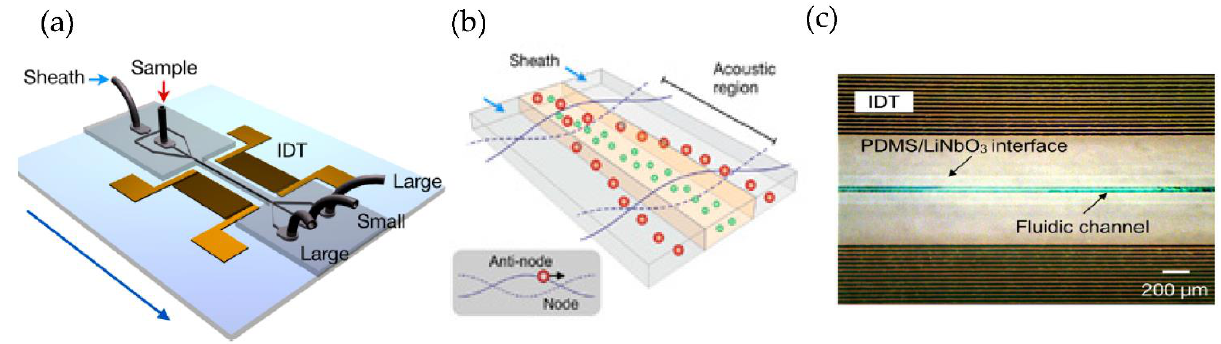
Figure 11. Experimental strategy for exosome immobilization and characterization using ExoChip ( a ) Schematic of exosome capture and analysis used in ExoChip. ( b ) Schematic for CirEVs fluorescence detection in micro-plate readers. (Reproduced from Kanwar S.S. et al. [76]. Copyright 2014, Lab Chip).